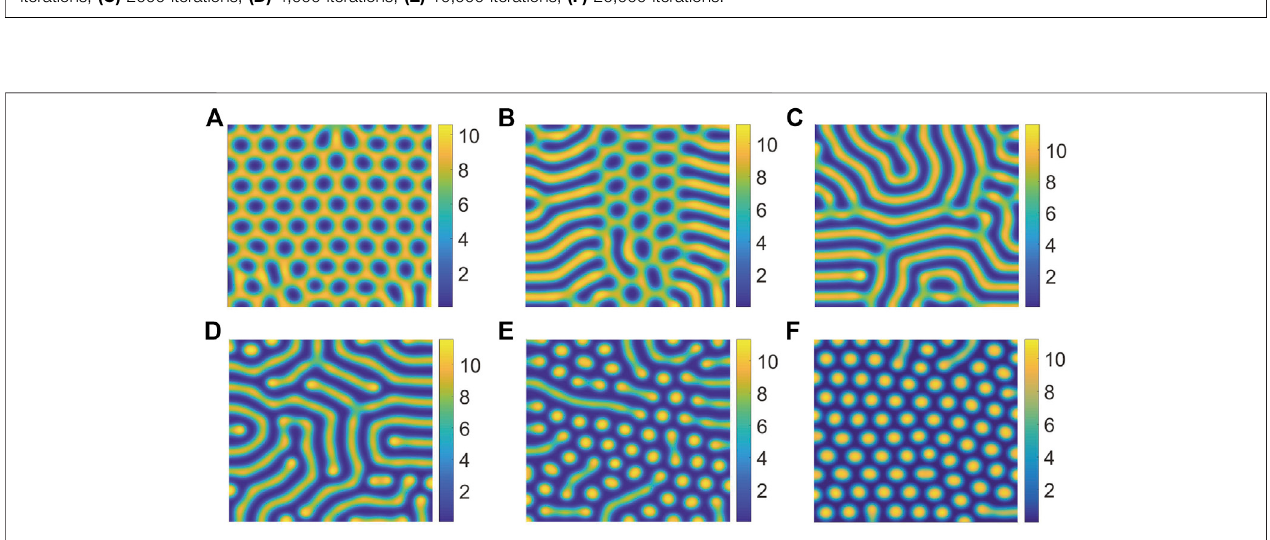
FIGURE 3 | Snapshots of contour pictures of the time evolution of vegetation at different instants with p (cid:1) 0.15, S (cid:1) 10, D (cid:1) 30 and B (cid:1) 5. (A) 0 iteration; (B) 1,000 iterations; (C) 2000 iterations; (D) 4,000 iterations; (E) 10,000 iterations; (F) 20,000 iterations.